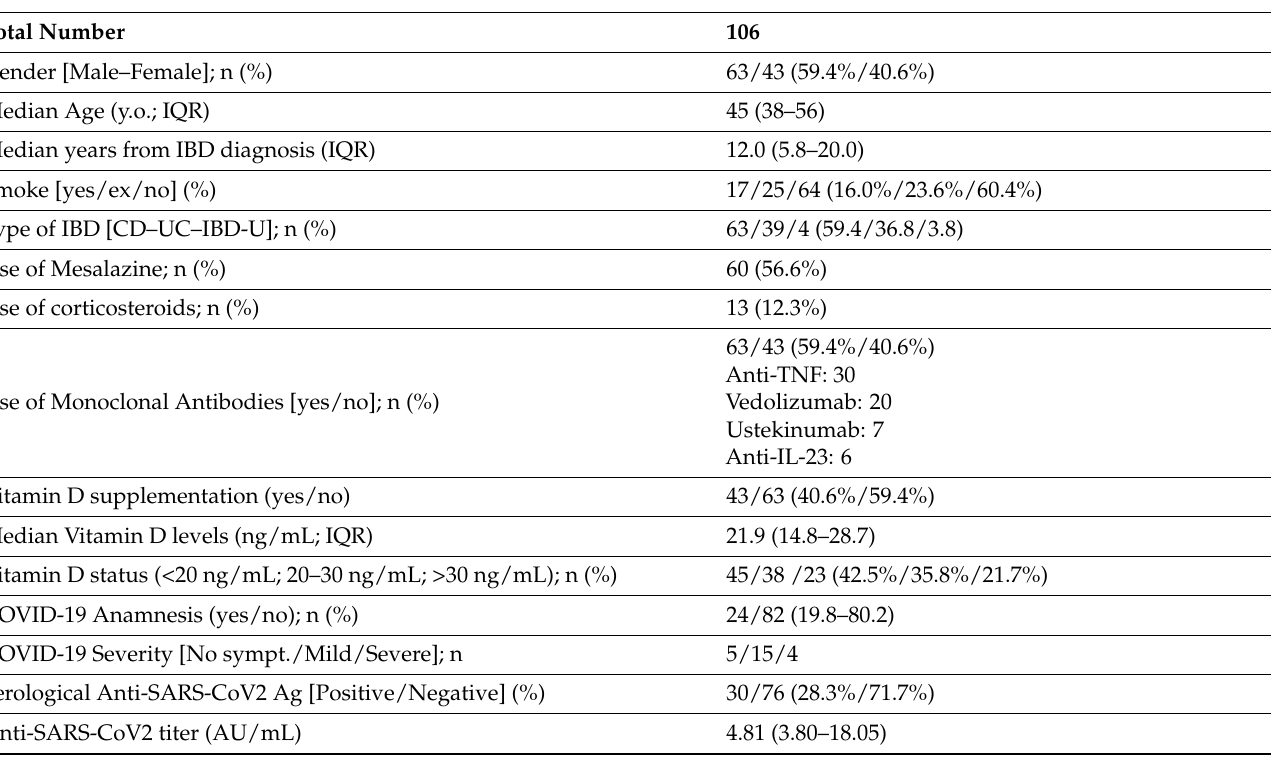
Table 1. Summary of patients’ characteristics on the day of enrolment. y.o. = years old; IQR = inter- quartile range; IBD = inflammatory bowel disease; CD = Crohn’s disease; UC = ulcerative